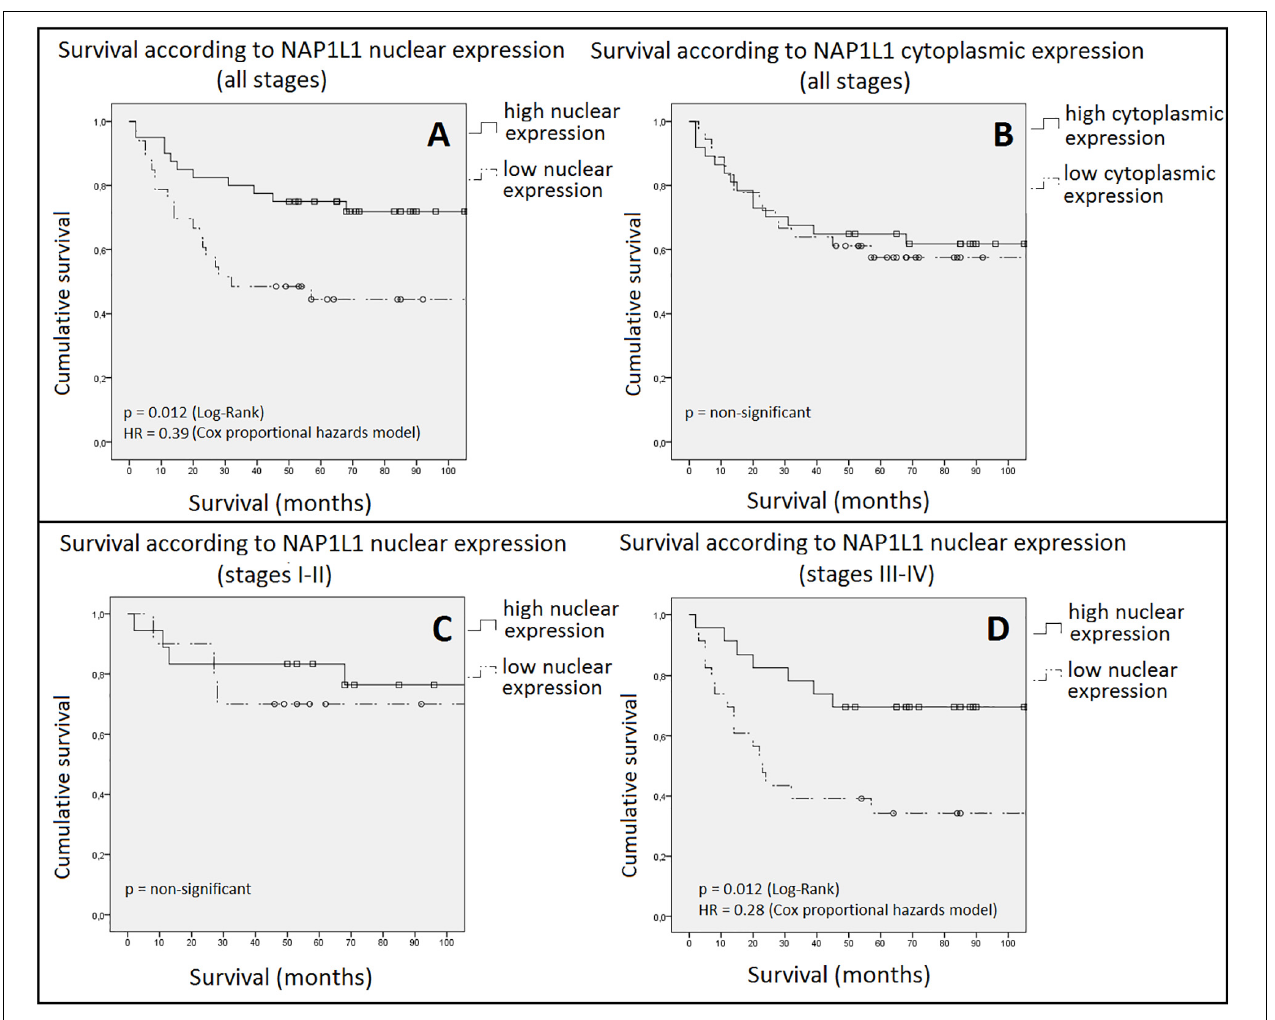
FIGURE 5 | Cumulative survival according to NAP1L1 expression. In panel (A) , nuclear staining is assessed. A highly significant ( p = 0.012) and clinically relevant (HR = 0.39 [95%CI: 0.17–0.87]) difference in survival between groups was observed favoring the high expression group. In panel (B) , cytoplasmic staining, no significant difference was observed. In panel (C) , nuclear expression for early stage disease (stages I and II) is assessed. No difference in survival was observed. Panel (D) shows the results for late stage disease (stages III and IV). A statistically significant difference was observed favoring the high nuclear expression group (HR: 0.28 [95%CI: 0.11–0.71]). Squares and circles = censored cases. HR: hazard ratio. CI: confidence